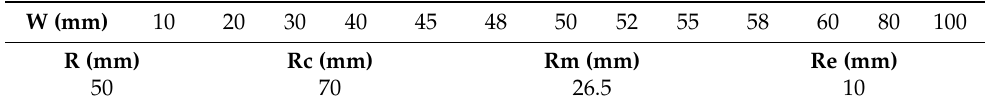
Figure 1. Experimental equipment and specimen: ( a ) Specimen geometry, ( b ) Schematic of the Marciniak acquisition system. Table 1. Dimensions of the specimen during different strain